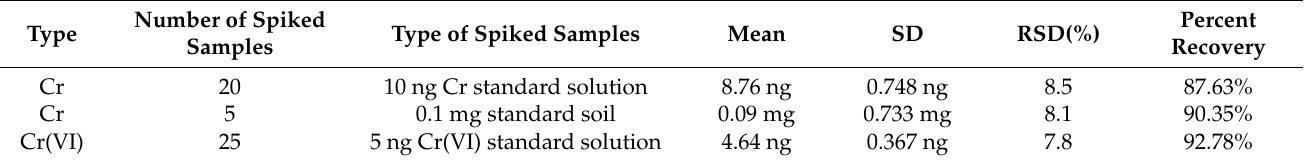
Table 4. The precision and recovery efficiency of